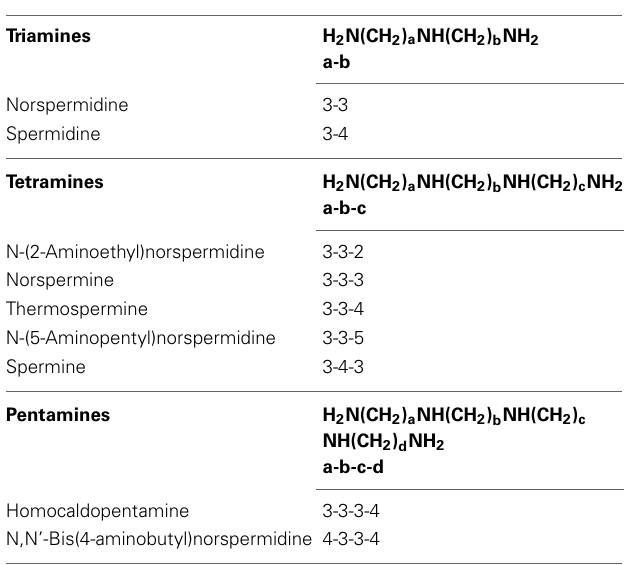
Table 1 | Linear polyamines used in this